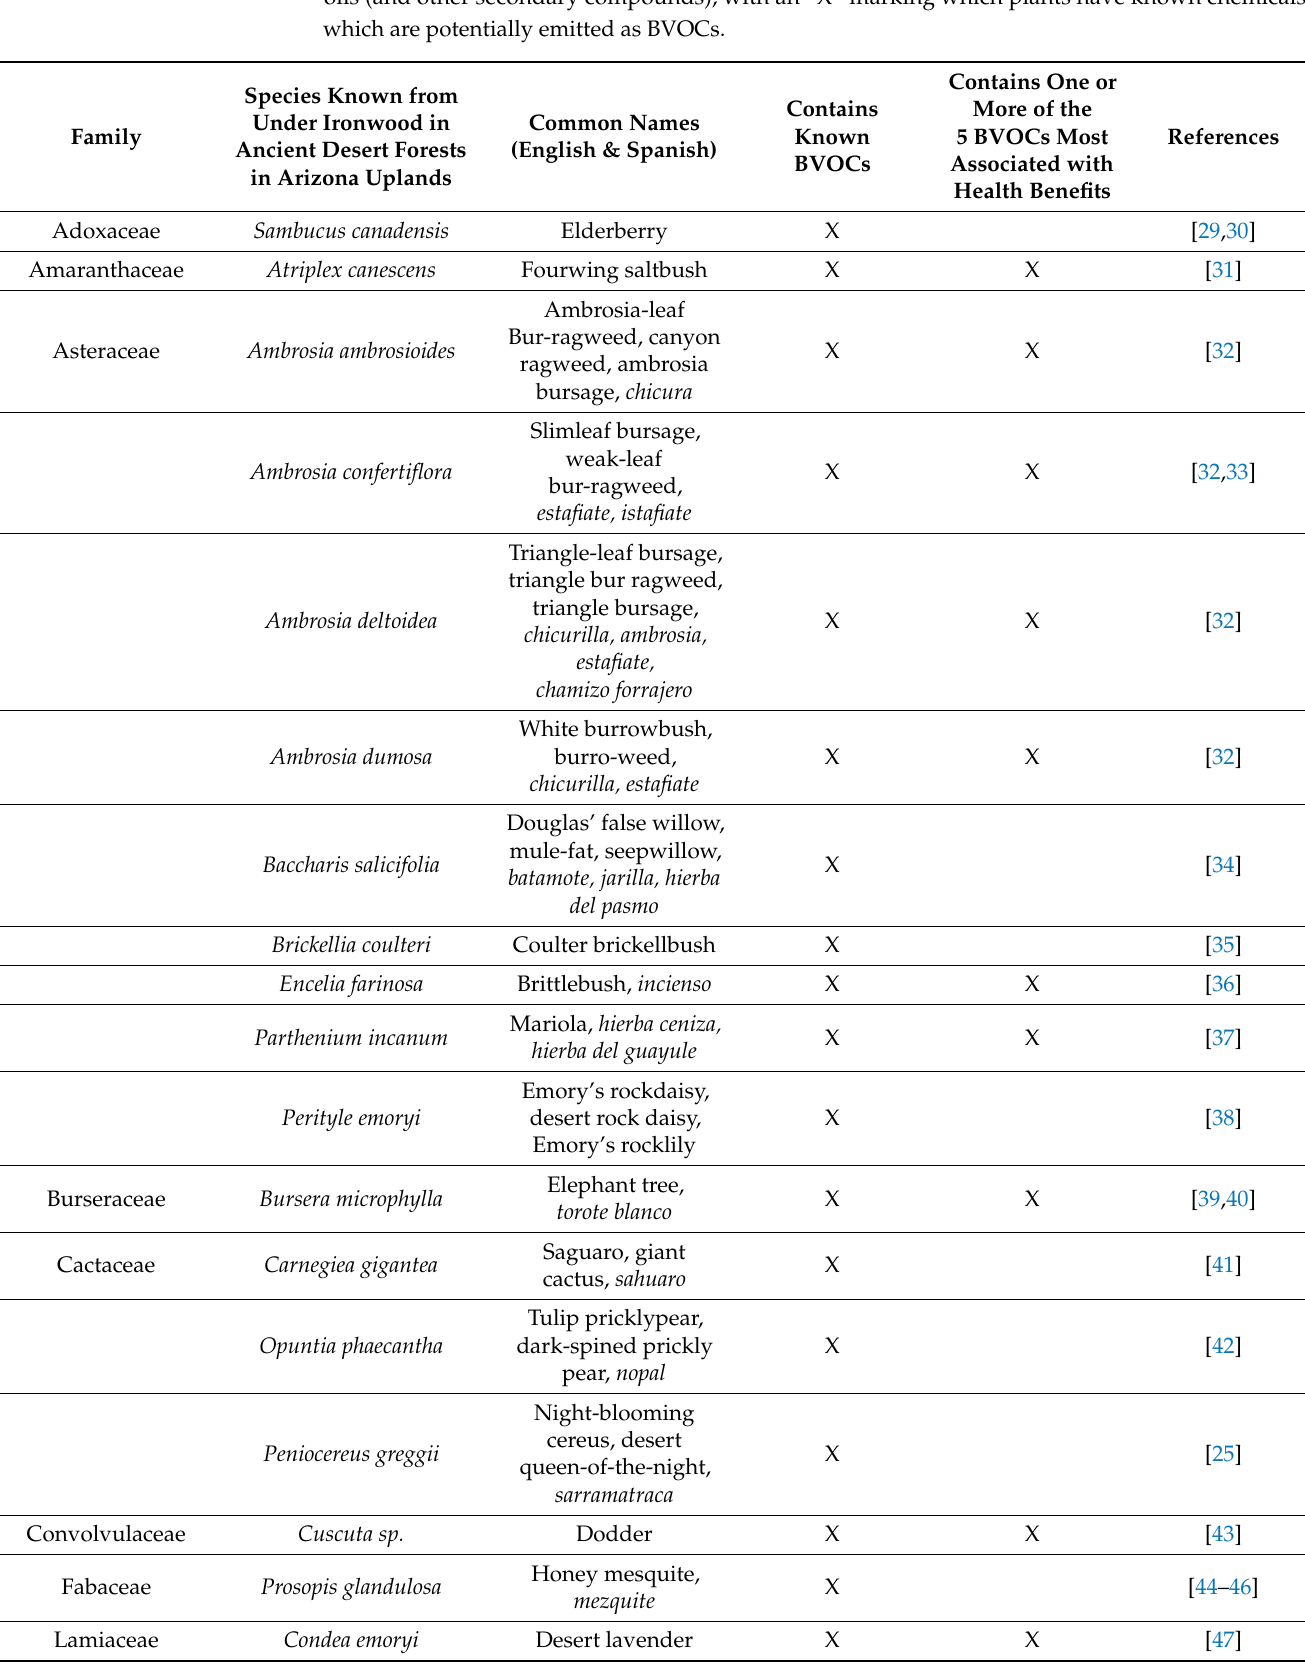
Table 2. Summary of the number of species from these two floras that have documented essential oils (and other secondary compounds), with an “X” marking which plants have known chemicals which are potentially emitted as